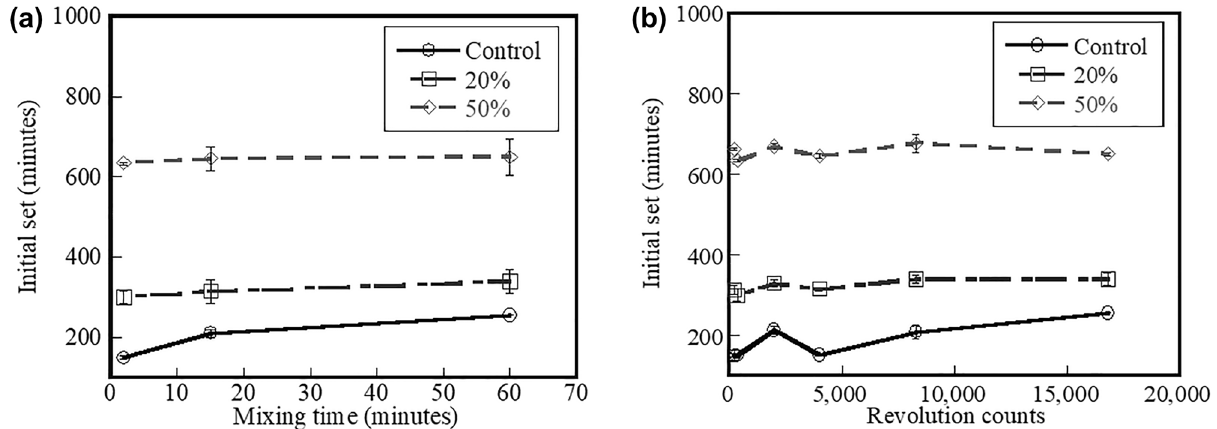
Figure 6. Effect of ( a ) mixing time and ( b ) mixer revolution counts on initial setting time of control system and systems containing 20% and 50% fly